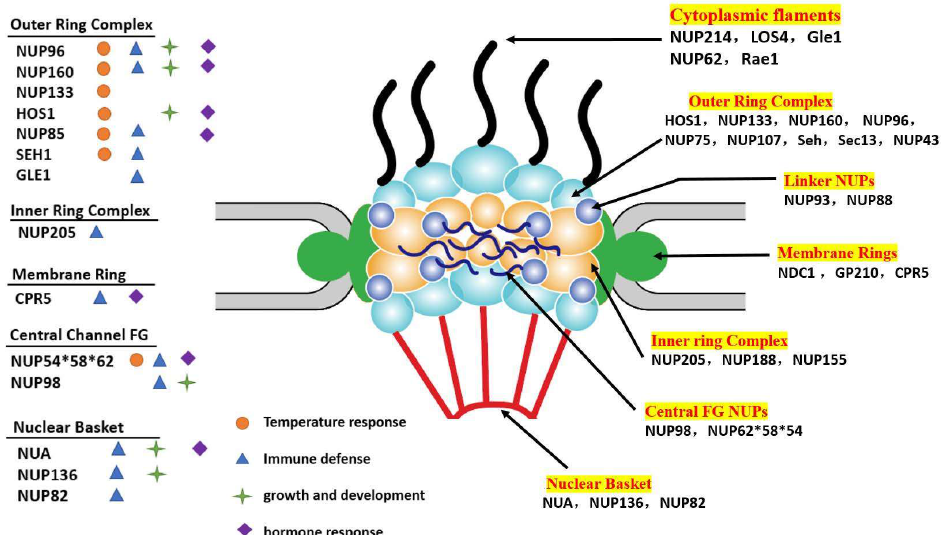
Figure 1. A model for the plant NPC structural organization and the role of plant NUPs in different biological processes. The NPCs consist of the following main components: scaffold nucleoporins include outer ring (blue), inner ring (yellow), the transmembrane ring nucleoporins (green), linker nucleoporins (purple), cytoplasmic filaments (dark) and nuclear basket (red), and central FG nucleoporins (dark purple). NUPs that have been functionally investigated in plants are underlined; and the left part lists some plant NUPs that have been reported to be involved in immune signaling (blue triangle), growth and development (green star), hormone response (purple diamond), and temperature response (orange cycle).